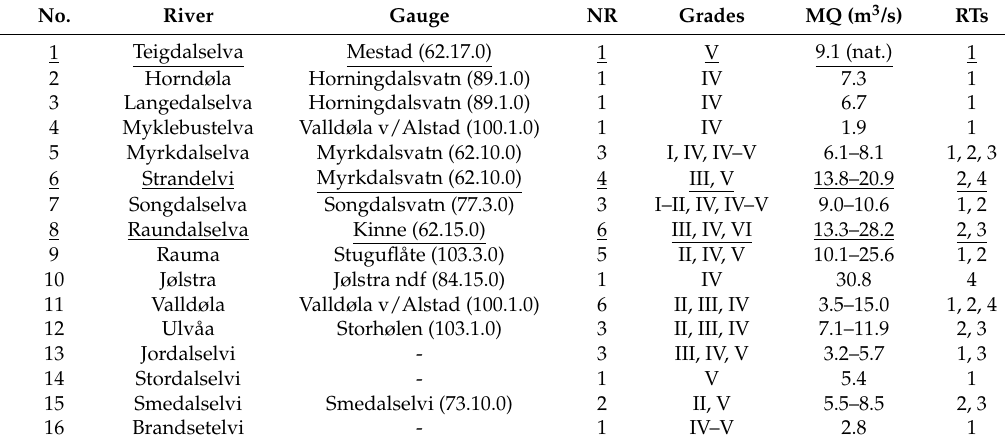
Figure 2. Overview map showing the location of the investigated river sections and their catchment areas, based on data from the State Map Agency (SK) and the Norwegian Water and Energy Directorate (NVE). Table 1. Overview of the investigated white water (WW) rivers in Western Norway. Rivers studied in more detail are underlined. Grades for No. 2–16 according to Nossum [23]. The range of mean discharges (MQ) is given for the WW runs (not the gauge). NR = number of runs; RT = run types according to Ligare et al. [1], see also Table 2.